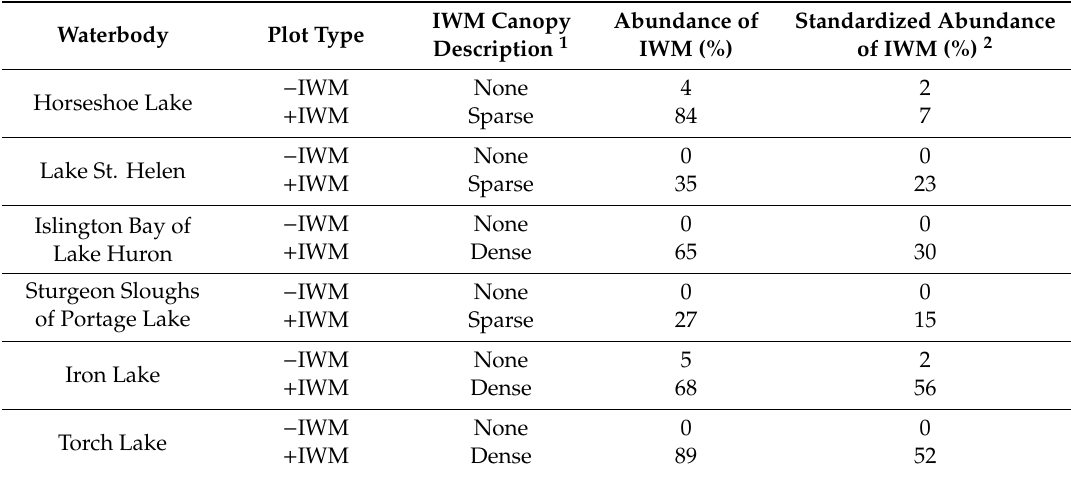
Table 3. Dominance of IWM by abundance and standardized abundance in each plot.